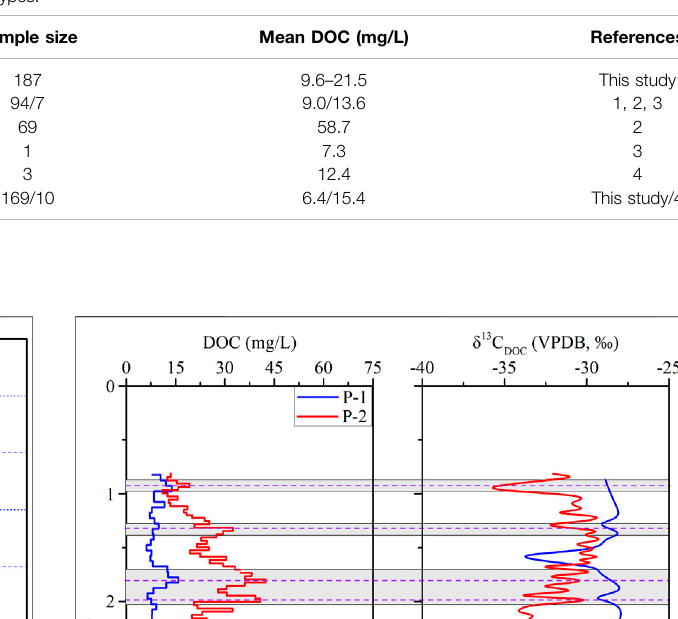
TABLE 2 | Variations in the DOC concentration among different ground ice types.